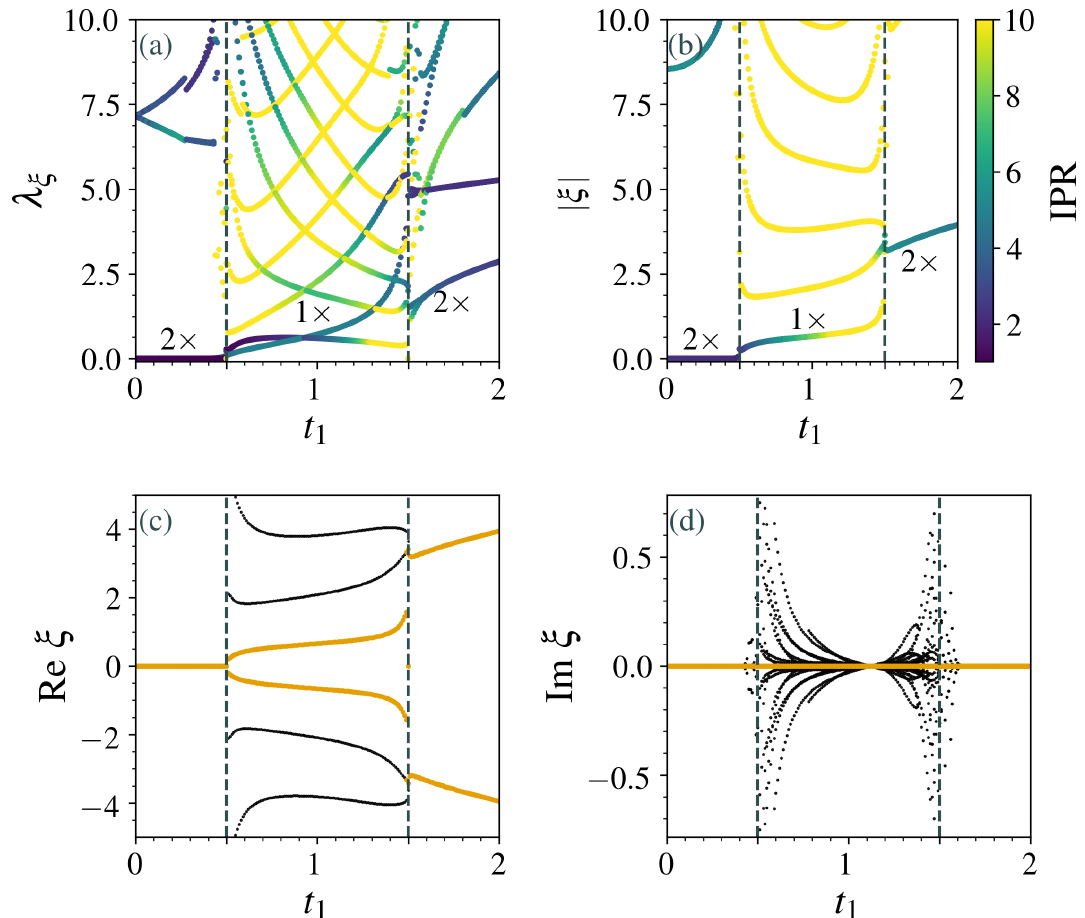
Figure 3: Singular values (a) and eigenvalues (b-d) of the biorthogonal entanglement Hamiltonian H RL as a function of t for γ = 0.5 and µ = 0. The total system is of 1 E length L = 201 and we consider a subsystem of size l = 40 unit-cells. In (a-b), colors represent the bilocalized inverse participation ratio of the corresponding singular modes I PR SVD and of the eigen modes I PR RL (see Eqs. (55) and (55) in App. B). In (c-d), we have highlighted (orange) the modes with the lowest real energies in = 0.5 and t = 1.5 — marked by the absolute values. Phase transitions occur at t 1 1 dashed vertical gray lines—, characterized by an entanglement gap closing in the singular values and the presence of extended states at low-energy. We also